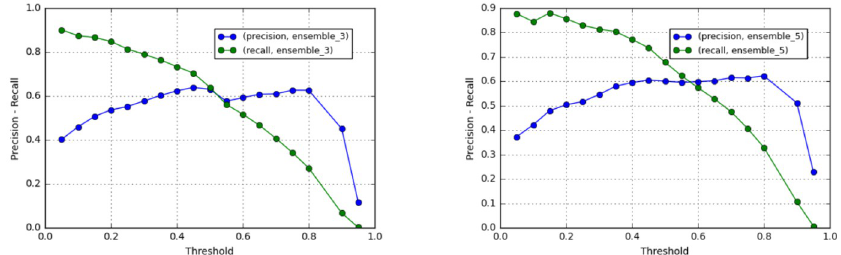
Fig 9. Precision and recall values of Ensemble3 (left) and Ensemble5 (right) with different classification threshold.